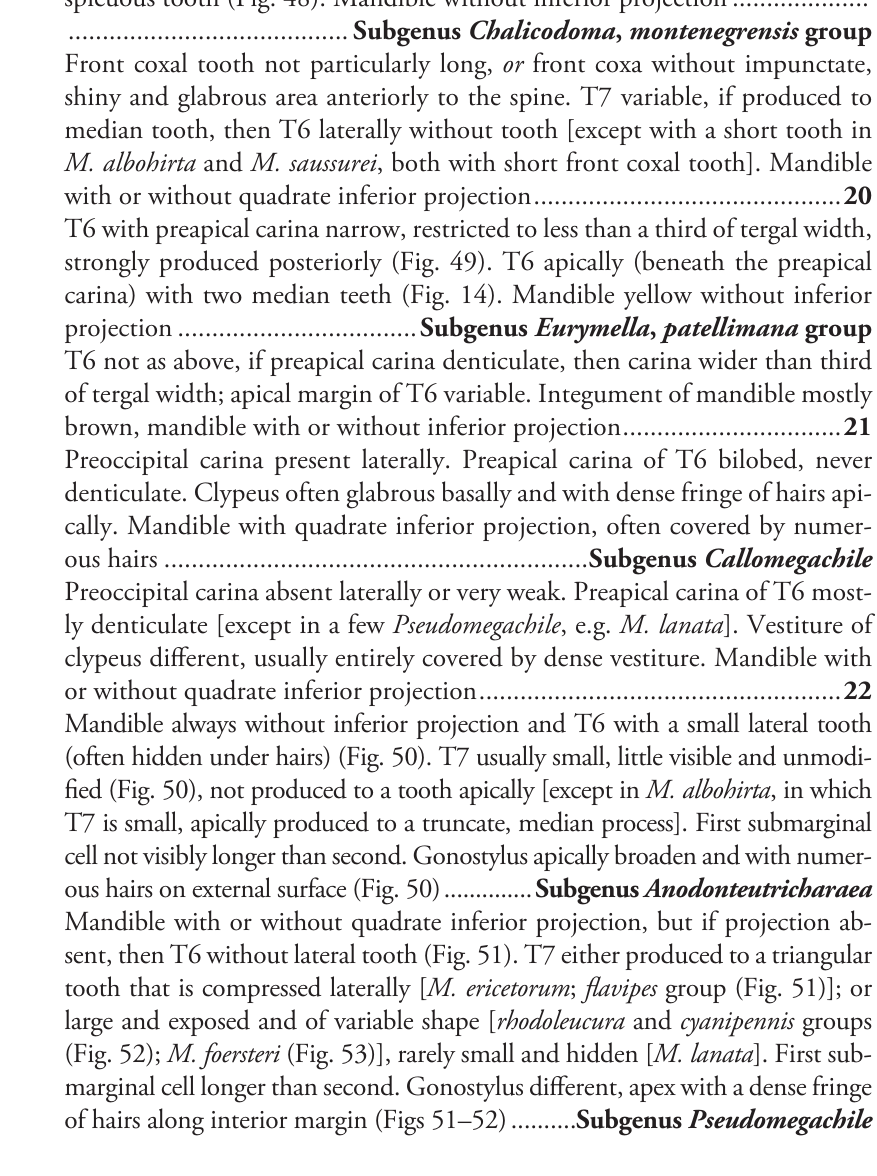
Species groups, species composition and biology of the Western Palearctic subgenera Subgenus